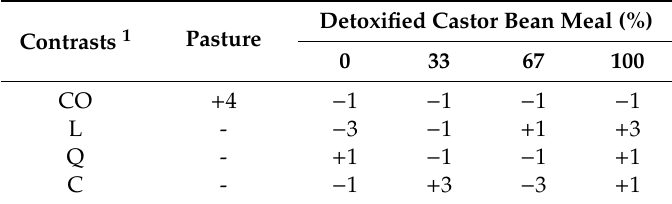
Table 4. Distribution of the coe ffi cients used in the contrasts. Detoxified Castor Bean Meal (%) Contrasts 1 Pasture 0 33 67 100 CO + 4 − 1 − 1 − 1 − 1 L - − 3 − 1 + 1 + 3 Q - + 1 −